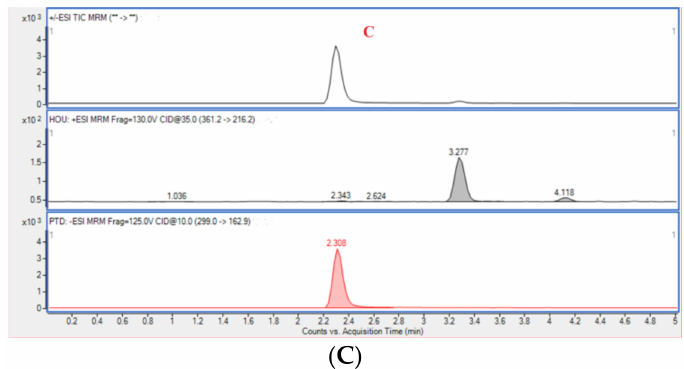
Figure 6. Typical multiple reaction monitoring (MRM) chromatograms of blank rat plasma ( A ), blank plasma sample spiked with analytes ( B ), and a plasma sample from a Houttuynia essential oil (HEO)-treated rat with p -Tolualdehyde-2,4- dinitrophenylhydrazone (PTD) ( C ).